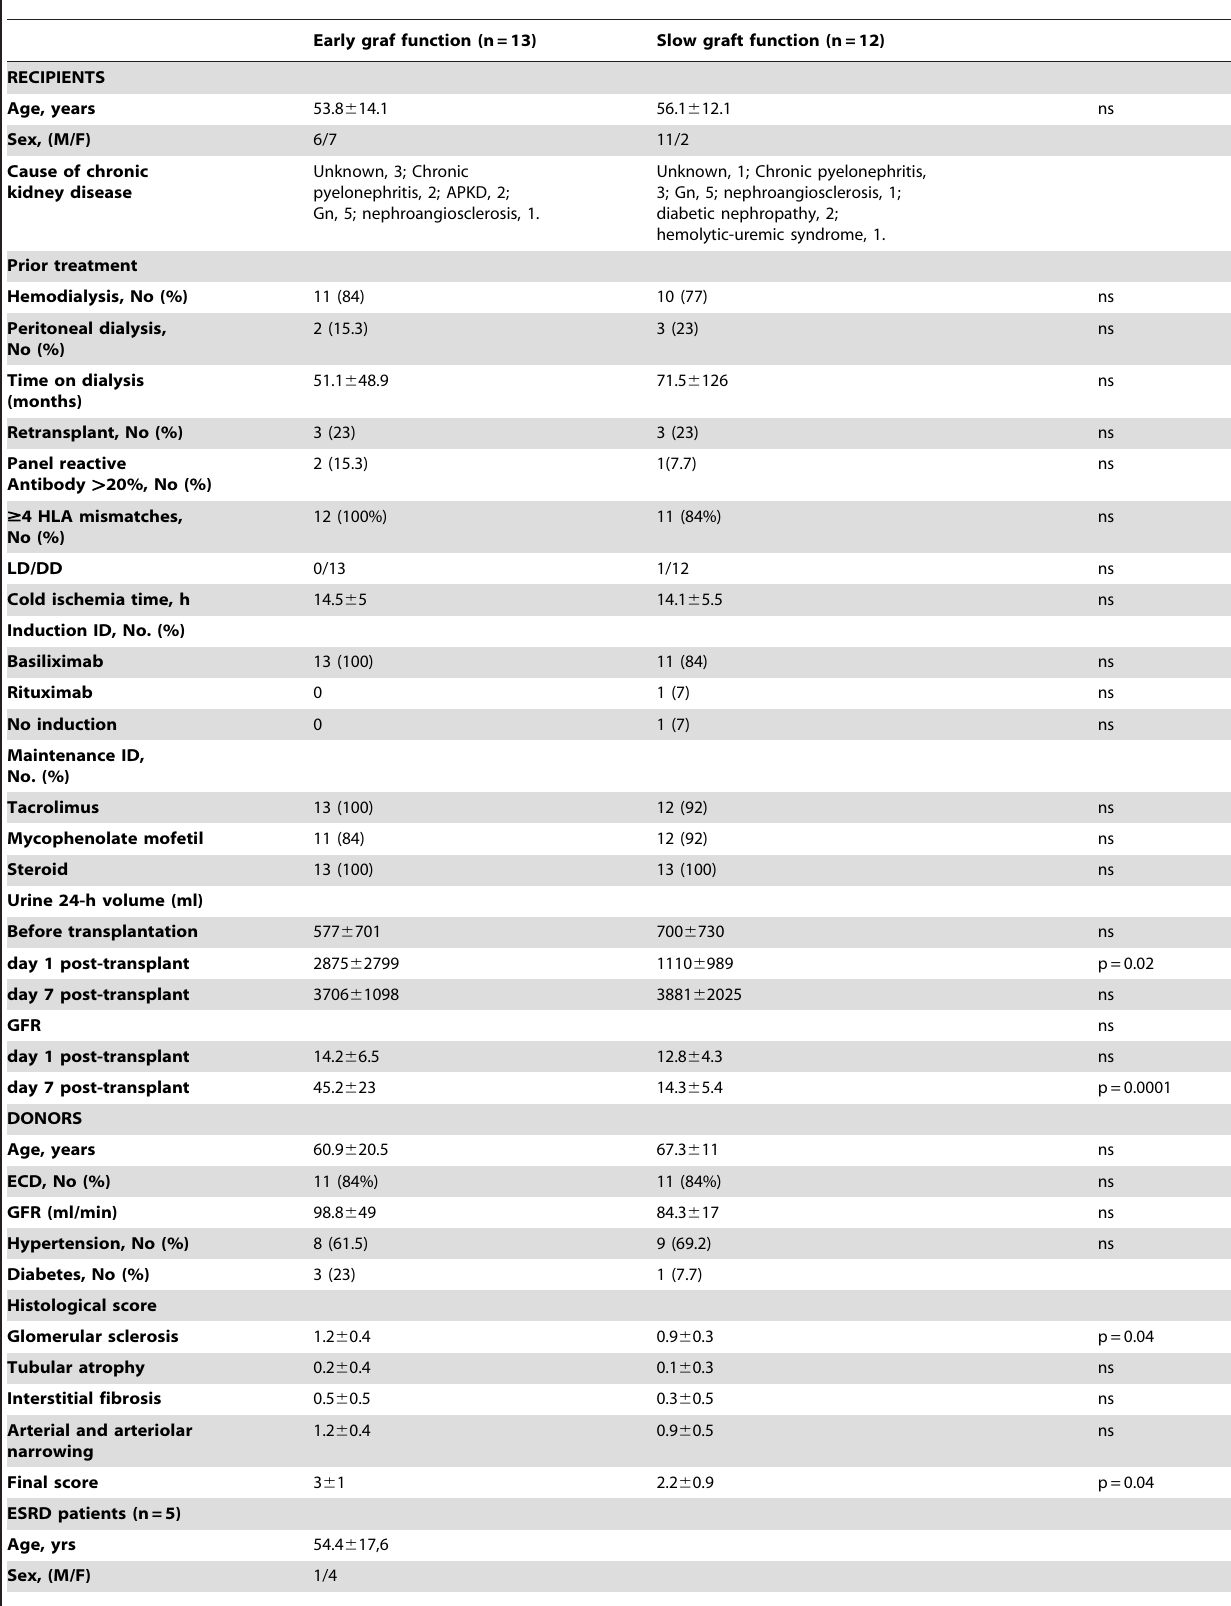
Table 1. Characteristics of the transplanted patients, ESRD patients and normal subjects in the